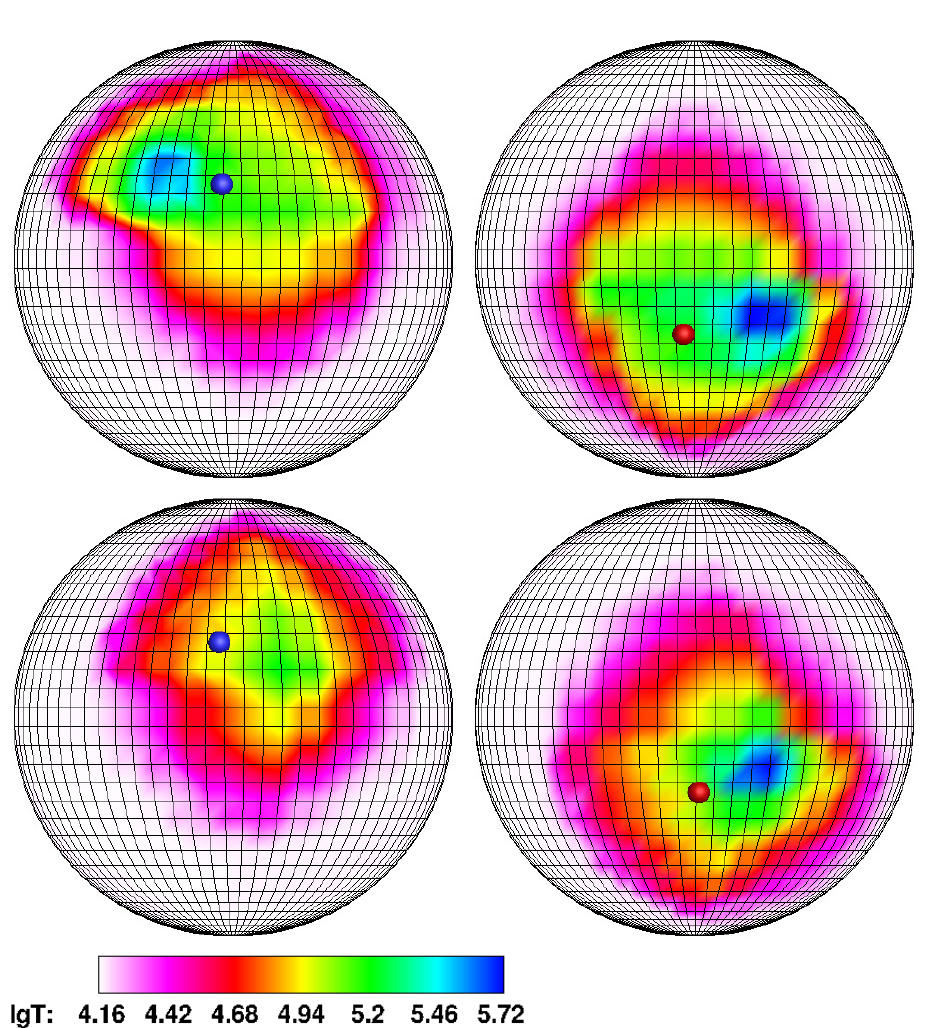
Figure 17. The same as in Figure 16, but for Phase 3 ( upper panel) and Phase 4 ( lower